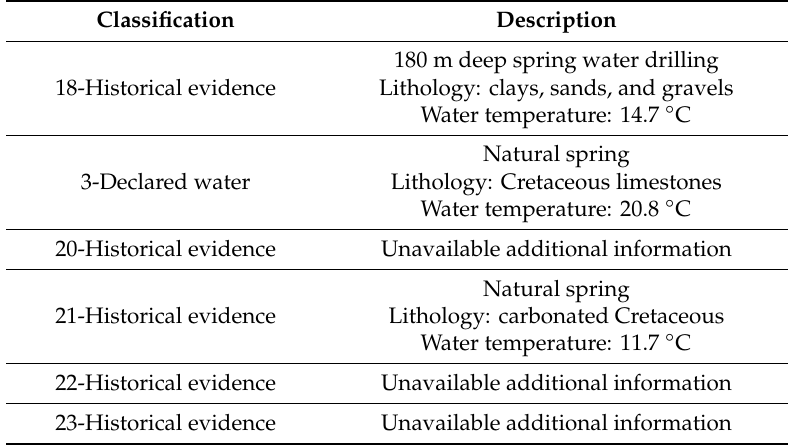
Table 1. Description of the water evidences close to the study area.